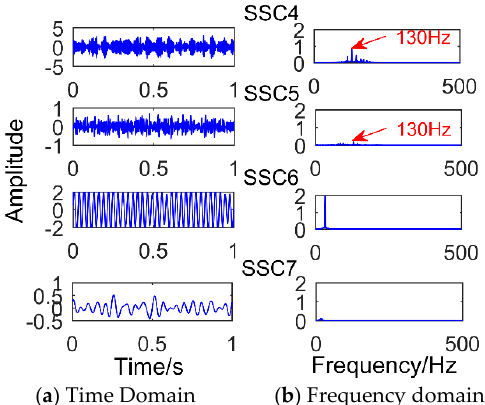
Figure 7. The results obtained by SSD for processing the synthetic signal when the amplitude of adding impact signal is 1. Sensors 2018 , 18 , x FOR PEER REVIEW